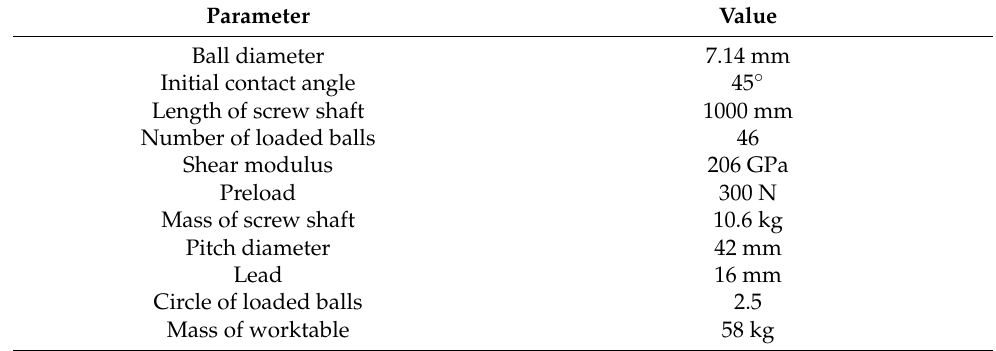
Table 2. Specifications of bearing.